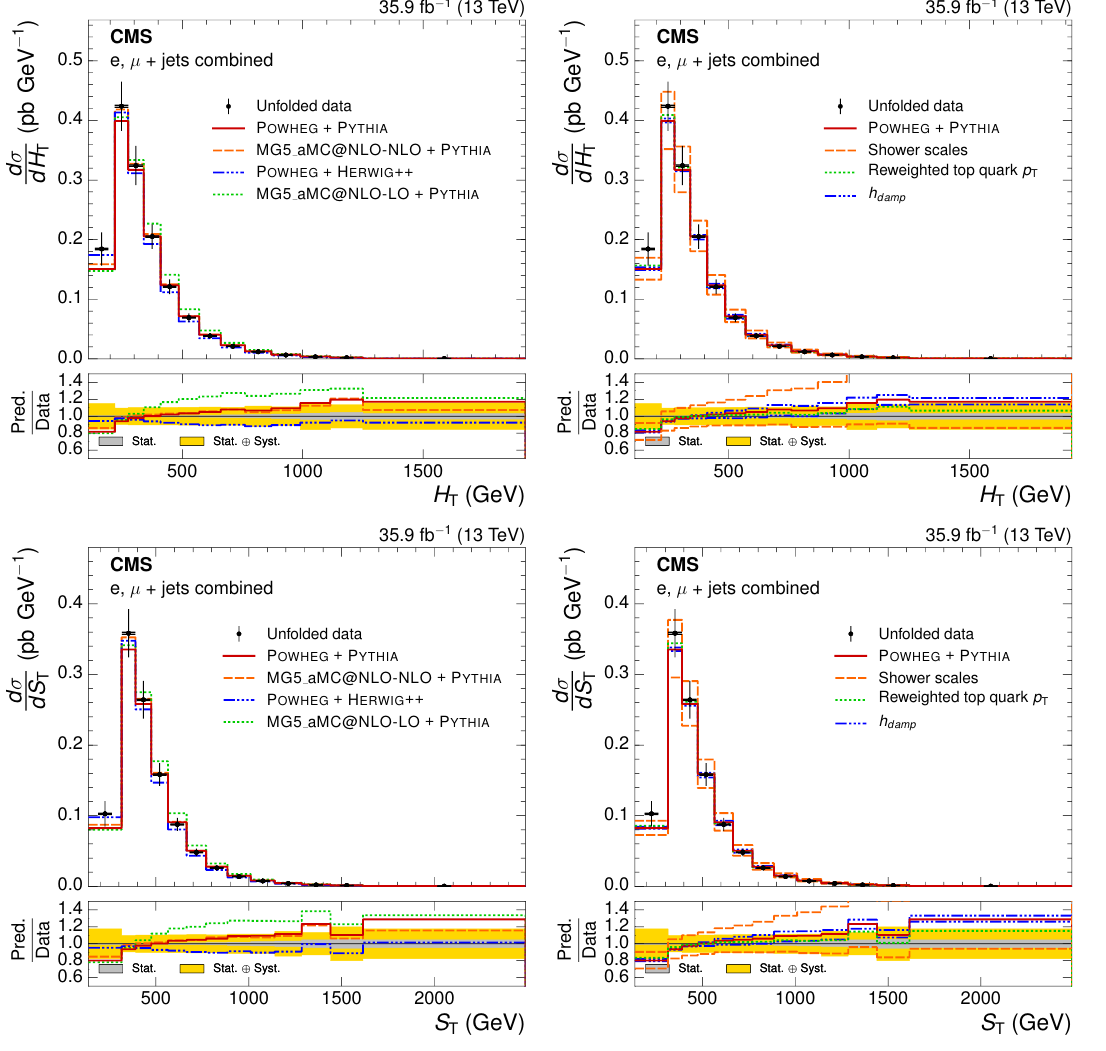
Figure 8 . Absolute H T (upper) and S T (lower) di(cid:11)erential tt cross sections, compared to di(cid:11)erent tt simulations in the left plots, and compared to the powheg + pythia simulation after varying the shower scales, and h damp parameter, within their uncertainties, in the right plots. The vertical bars on the data represent the statistical and systematic uncertainties added in quadrature. The bottom panels show the ratio of the predictions to the